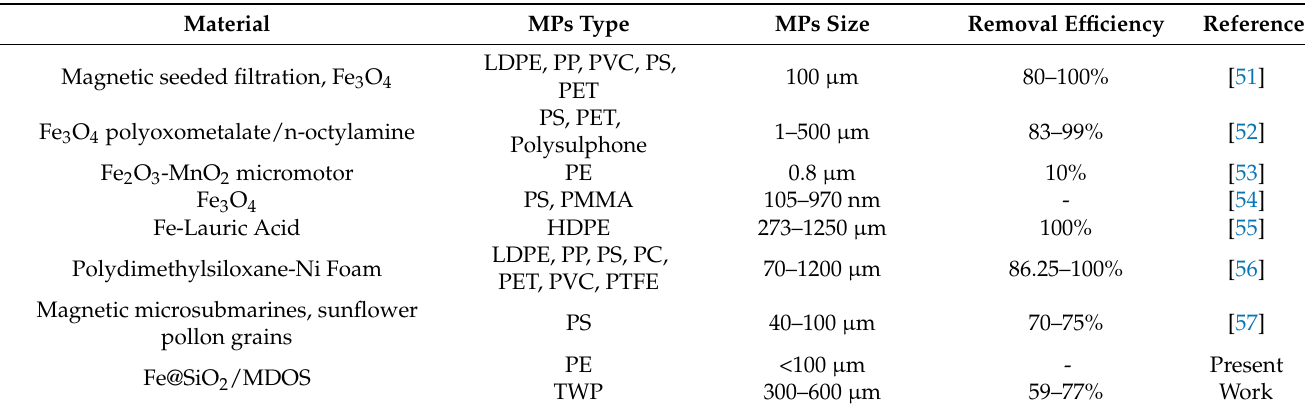
Figure S2: TGA of Road Dust. First differential is shown in the inset; Video S1: Magnetic Extraction of Polyethylene; Video S2: Magnetic Extraction of Tire Wear